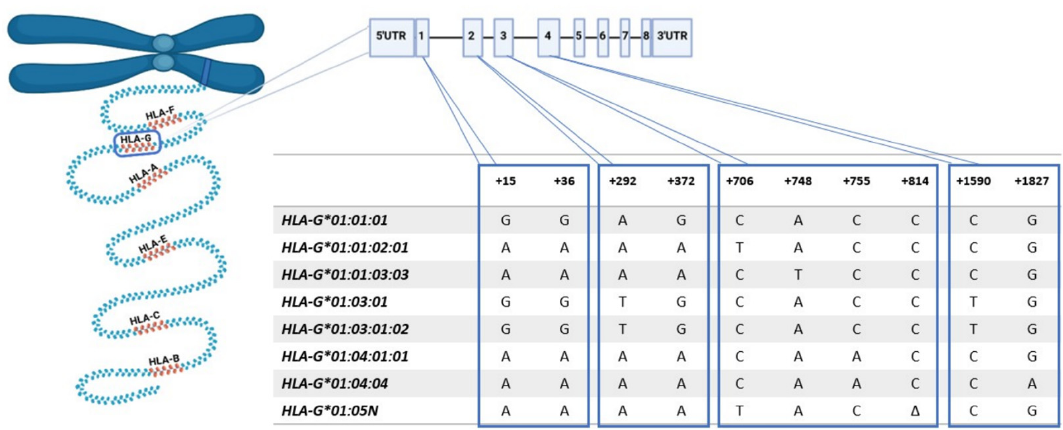
Figure 4. HLA-G genotyping: Nucleotide sequences of the eight alleles found in this study (IMGT version 3.46.0, 11 October 2021).